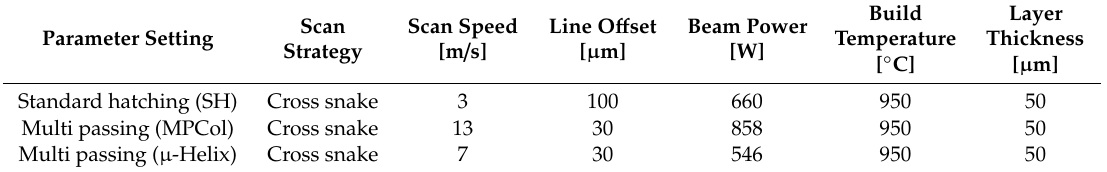
Table 1. Selective Electron Beam Melting (SEBM) processing parameters for trapezoid samples. Parameter Setting